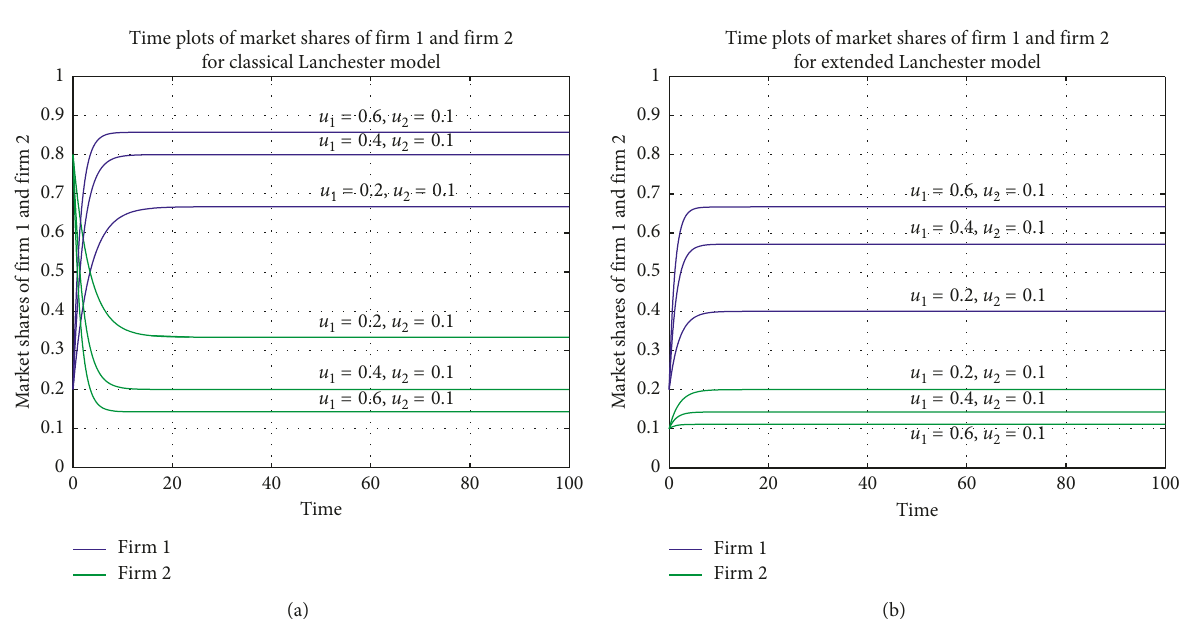
( u � c ) with parameters i i 1